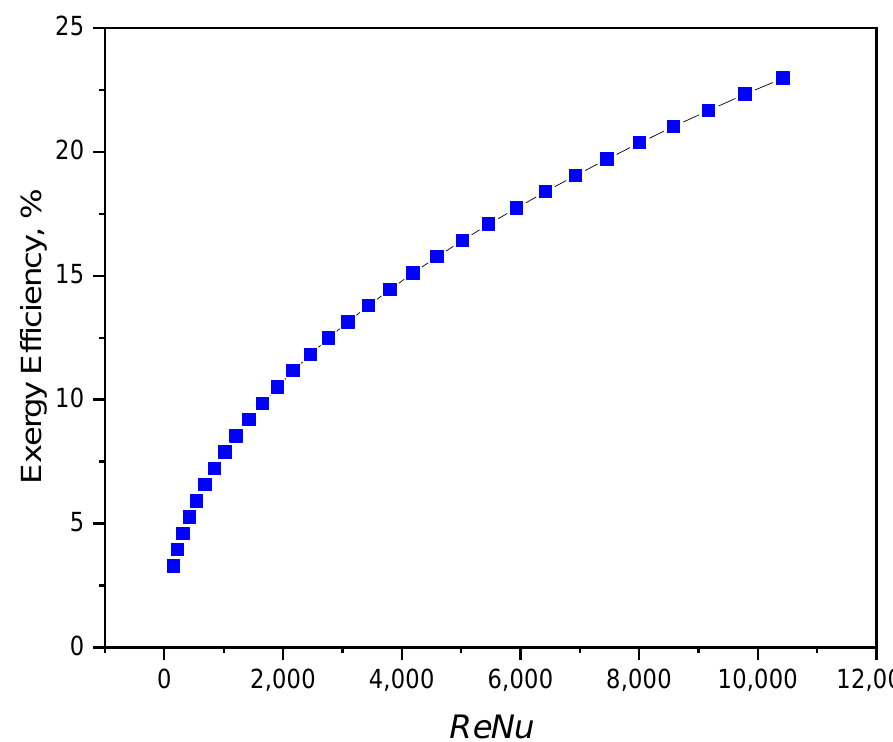
Figure 7. Correlation between non-dimensional parameters and exergy efficiency for CuO/water (φ = 2%) nanofluid with different volume flow rates.